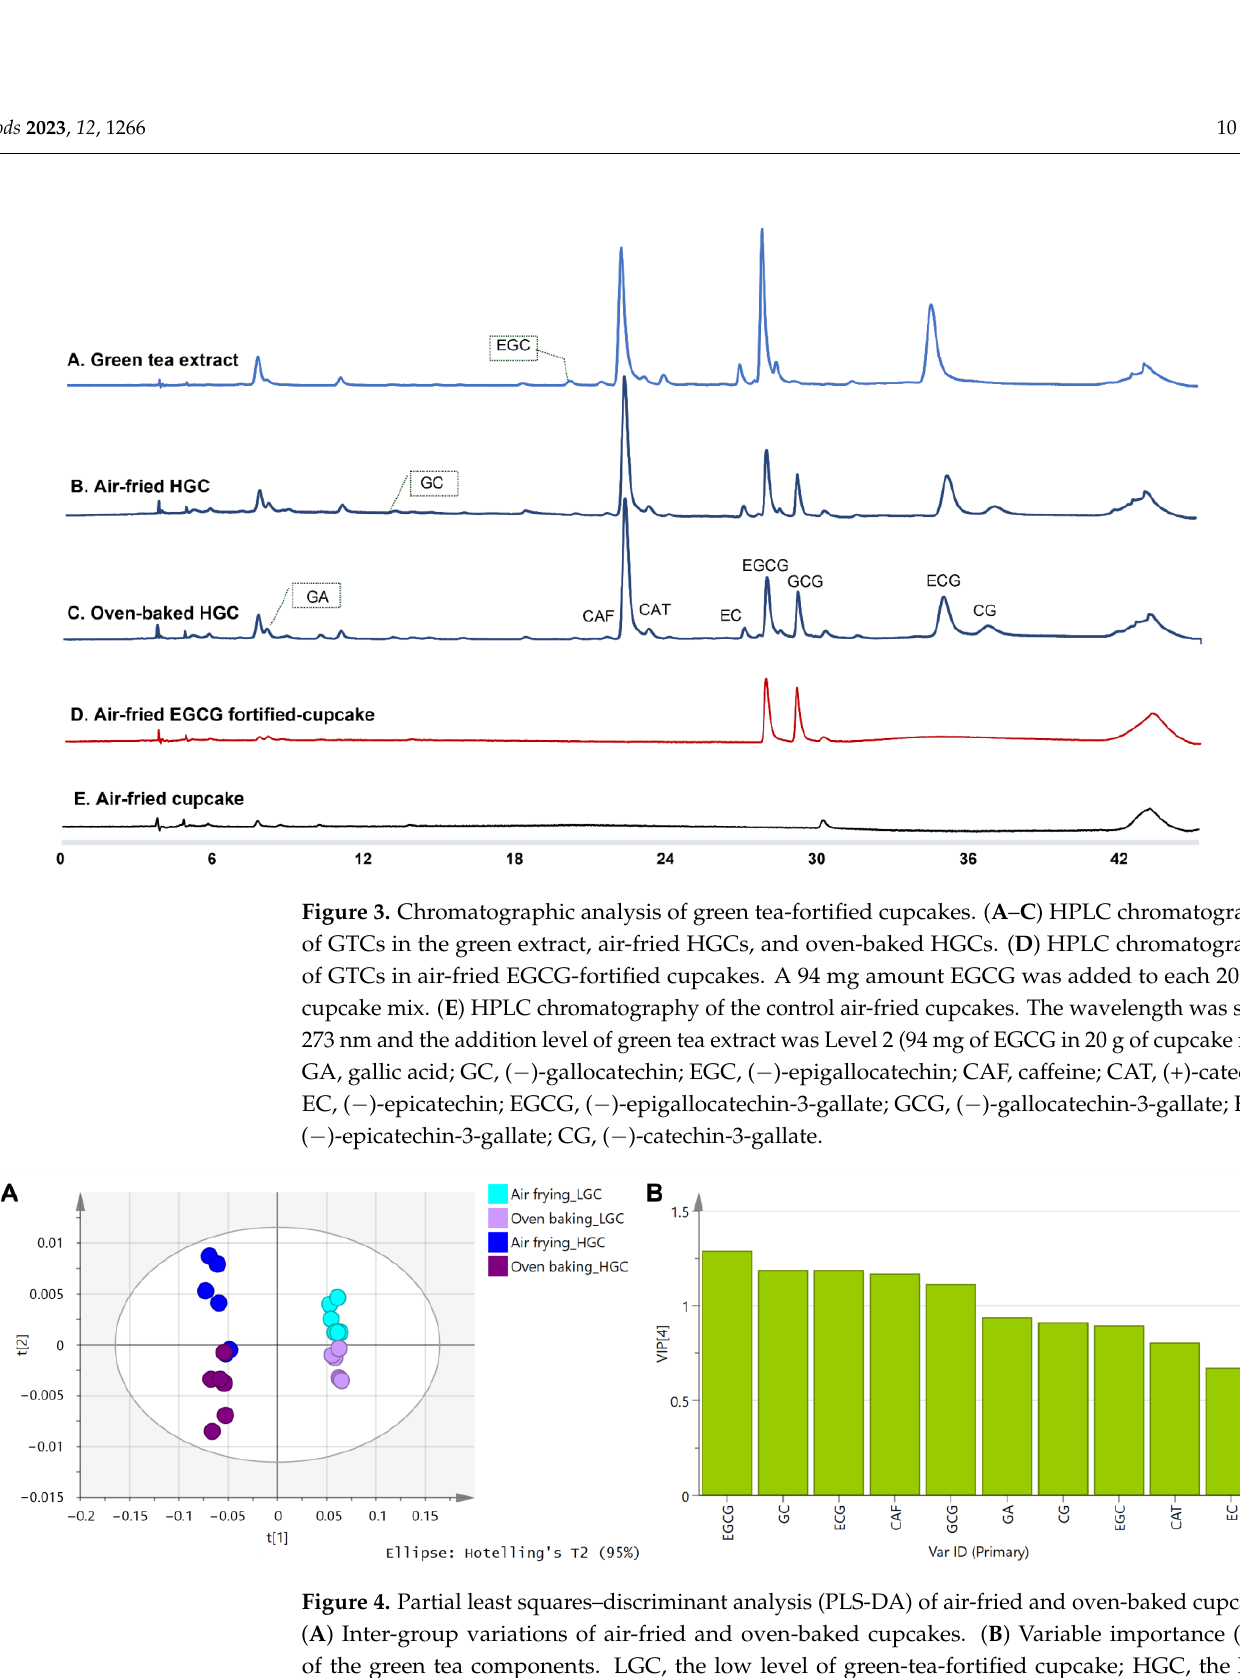
Figure 4. Partial least squares–discriminant analysis (PLS-DA) of air-fried and oven-baked cupcakes. ( A ) Inter-group variations of air-fried and oven-baked cupcakes. ( B ) Variable importance (VIP) of the green tea components. LGC, the low level of green-tea-fortified cupcake; HGC, the high level of green-tea-fortified cupcake; EGCG, (−)-epigallocatechin-3-gallate; GC, (−)-gallocatechin; ECG, (−)- epicatechin-3-gallate; CAF, caffeine; GCG, (−)-gallocatechin-3-gallate; GA, gallic acid; CG, (−)-cate- chin-3-gallate; EGC, (−)-epigallocatechin; CAT, (+)-catechin; EC, (−)-epicatechin. The levels of green tea components from the two different matrices were evaluated individually. As presented in Figure 5, in the LGC groups, EC (Figure 5F), EGCG (Figure 5G), and ECG (Figure 5I) extracted from the oven-baked cupcakes were lower in amount than those from the air-fried cupcakes, while the amount of CAT (Figure 5E), GCG (Figure 5H), and CG (Figure 5J) were higher. Although these results had no significant difference,